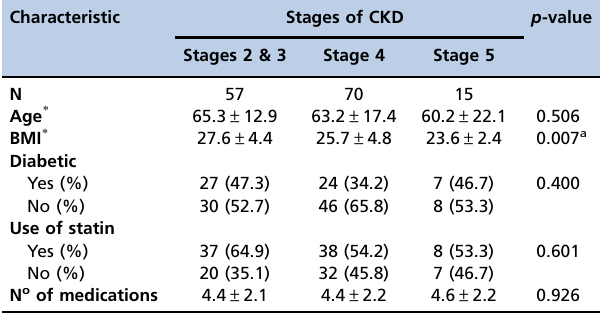
Table 3 - A linear regression of the clinical and laboratory characteristics according to the GFRs of the 142 patients with predialysis CKD.